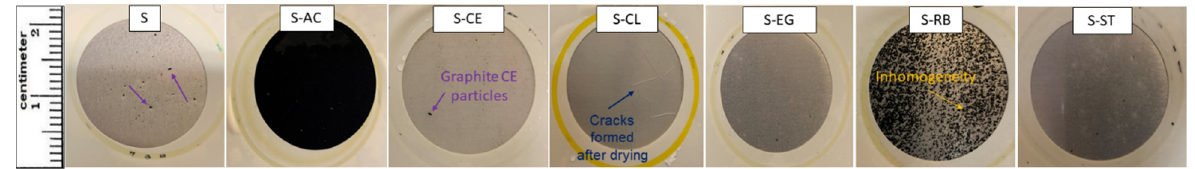
Figure 6. Digital photo images of the Al-coated samples after exposure to the 3.5 wt.% NaCl for 30 days.